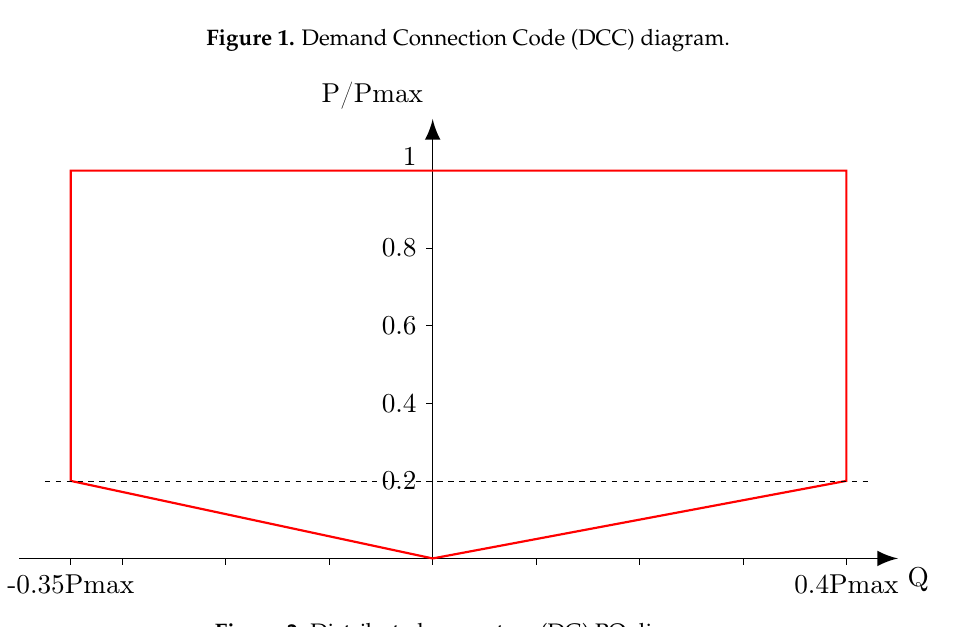
Figure 1. Demand Connection Code (DCC) diagram.